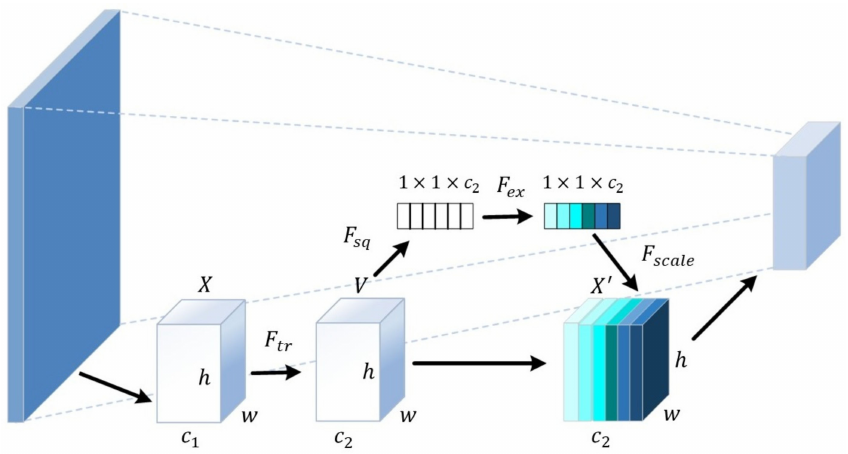
Figure 6. The realization process of the SENet attention mechanism. Different colors represent different weights. The main principle is to introduce the attention mechanism on the channel dimension in the CNN convolution process. For the feature map X with the given dimension c 1 × w × h , the feature map V with the dimension c 2 × w × h is obtained after an ordinary convolution transformation. After the